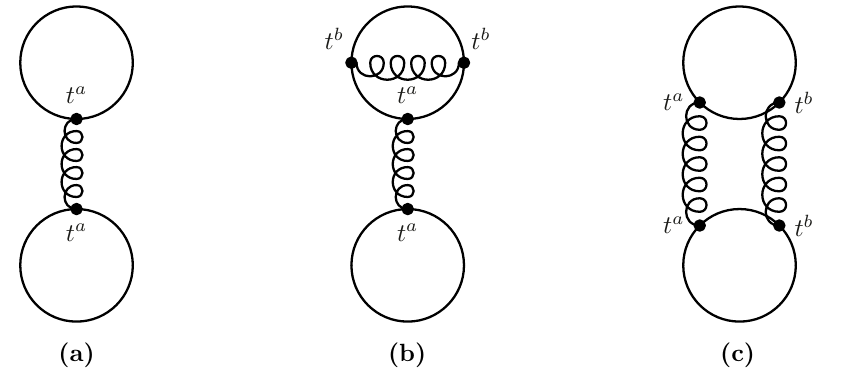
Figure 2 . Examples of the color component of NLO and NNLO Feynman diagrams for t -channel single top-quark production. Both virtual and real diagrams can be represented in this form. The lower loop represents the heavy-quark line, whereas the upper loop represents the light-quark